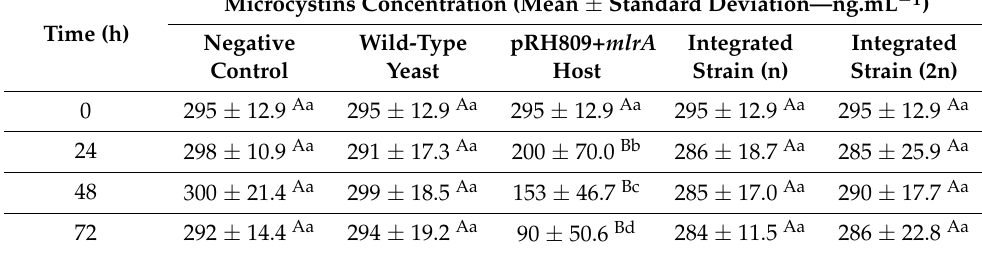
Table 2. MCs degradation test during 72 h of yeast growth *.